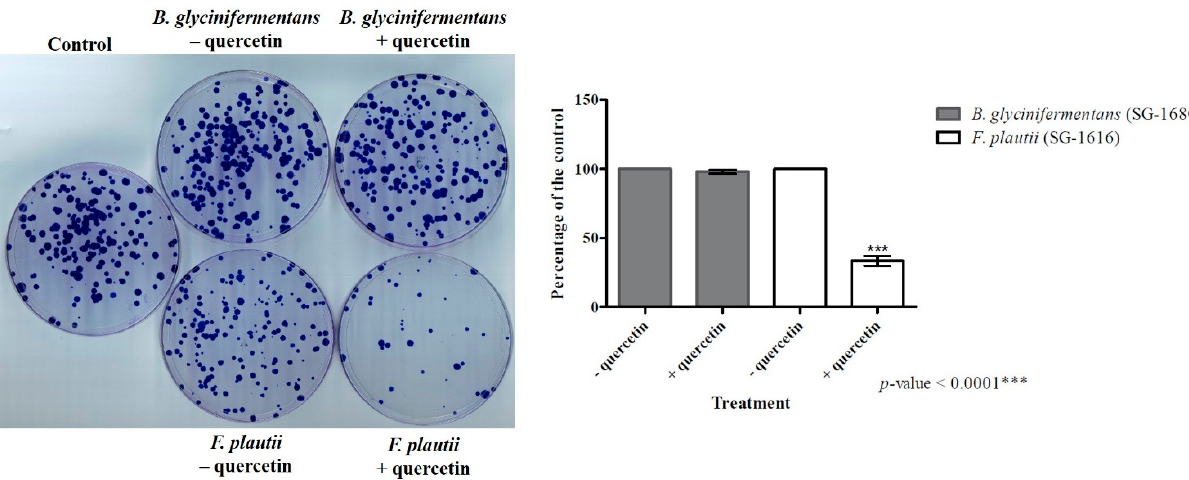
Figure 9. Clonogenic assay using the HCT-116 cells treated with the spent bacterial culture supernatants. Effect of the spent supernatants from the B. glycinifermentans and F. plautii cultures grown in the absence ( − quercetin) and presence (+ quercetin) of quercetin on colony formation in the HCT-116 cells. Quantification of the data is shown beside the crystal violet-stained images of the colonies. The graph is represented as the means ± standard deviation. While in some plates the distribution of the 500 cells seeded was homogeneous, others had clusters of cells localized to certain regions of the plate, owing to their placement in the incubator. All the plates were, however, seeded with 500 cells/plate and allowed to form colonies.